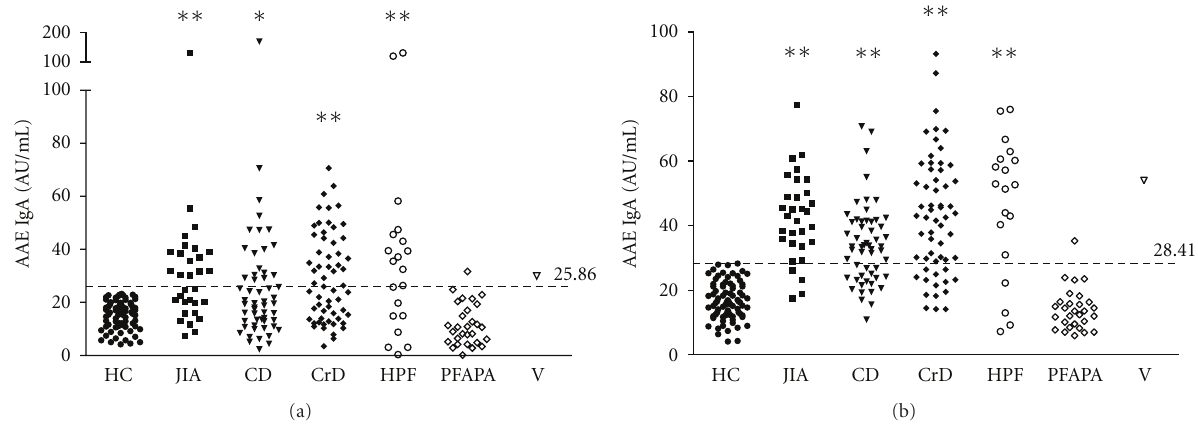
Figure 1: Levels of anti- α -enolase antibodies ((a): IgG; (b): IgA) in patients with juvenile idiopathic arthritis (JIA), celiac disease (CD), Crohn’s disease (CrD), hereditary periodic fevers (HPF), PFAPA syndrome (PFAPA), and vasculitis (V) and healthy controls (HC). Results are expressed as arbitrary units per mL (AU/mL). Cut-o ff values are indicated with a dashed line. Patients’ antibody levels are compared to healthy control by t -test ( ∗∗ = P < 0,001, ∗ = P < 0,05).